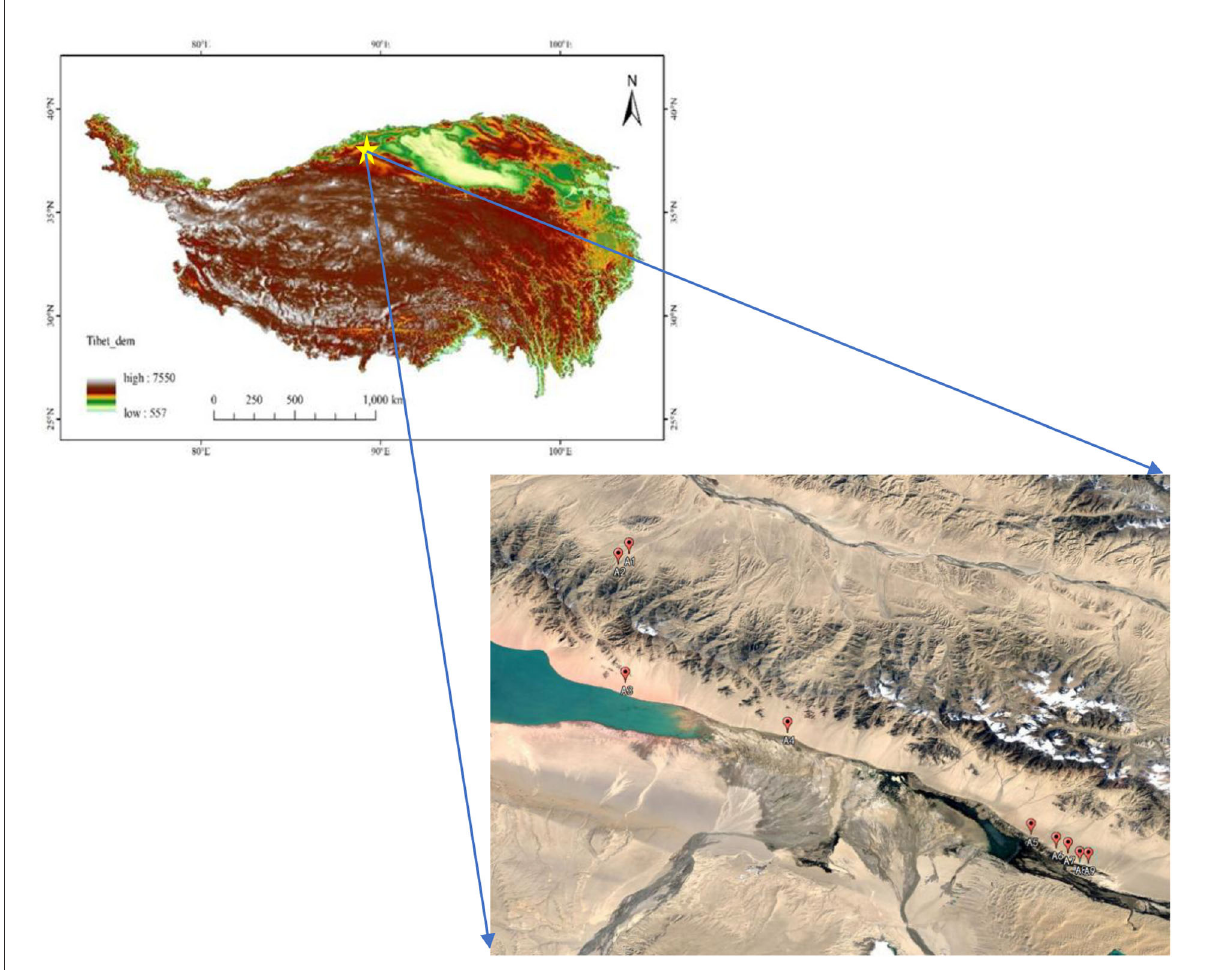
FIGURE1 Distribution of sample